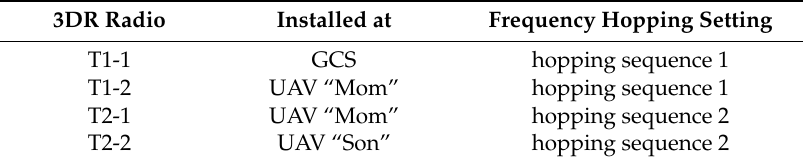
Figure 5. Time division multiplexing (TDM) working principle.